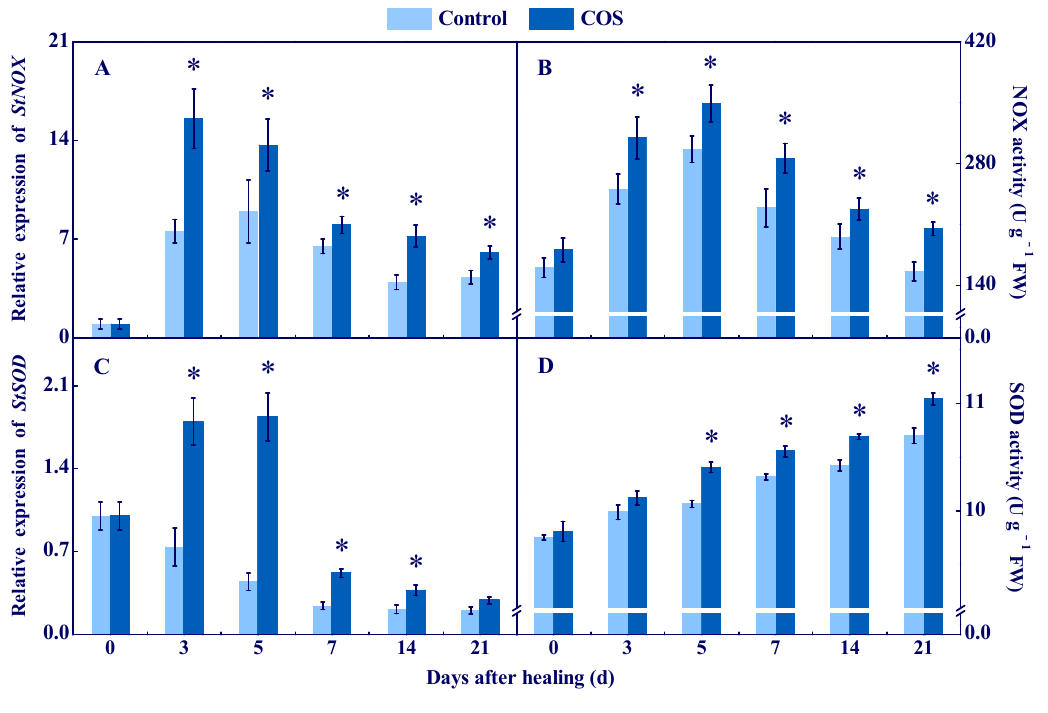
Figure 1. Effect of COS treatment on the relative expression of StNOX ( A ) and StSOD ( C ), and the activities of NOX ( B ) and SOD ( D ) at wounds of potato tubers during healing. Bars indicate standard error. Asterisks denote significant differences ( p < 0.05). The peak of O 2 ●− content was found at 5 d of healing in all groups, while the COS group maintained a higher value during healing, which was 37.6% higher than that of the control at 5 d (Figure 2A). The H 2 O 2 content peaked at 14 d in all groups, while the COS group maintained a higher value during healing (Figure 2B).